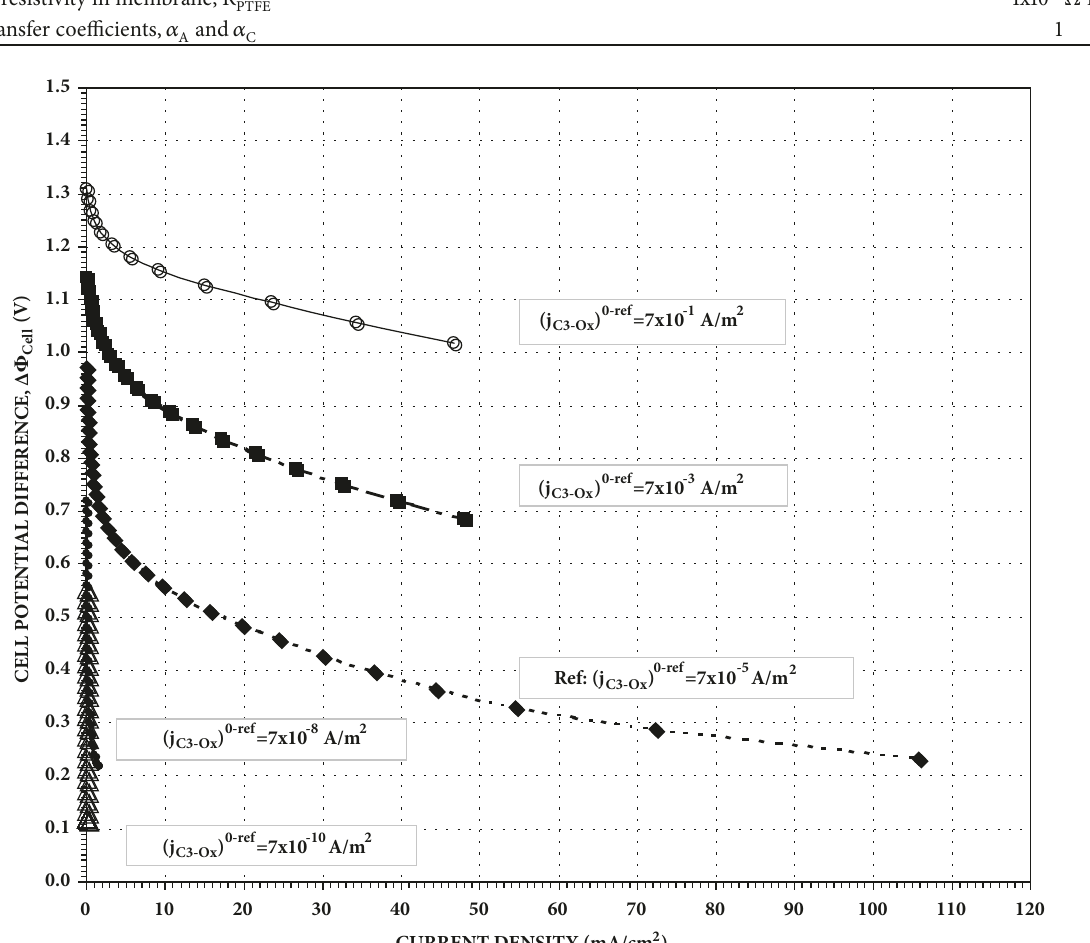
) 0-ref (A/m 2 ), on the polarization curve for a direct propane fuel Figure 3: The effect of the anode reference exchange current density, ( j C3-Ox ) 0-ref (A/m 2 ) for the above five cases were represented by the following symbols: (i) cell model (DPFC) at 150 ∘ C and 1 atm. The values of ( j C3-Ox open circles: 7x10 −1 A/m 2 , (ii) solid squares: 7x10 −3 A/m 2 , (iii) solid diamonds: 7x10 −5 A/m 2 (reference case), (iv) solid circles: 7x10 −8 A/m 2 , and (v) open triangles: 7x10 −10 A/m 2 . All the other parameters were the same as the reference case mentioned in Table